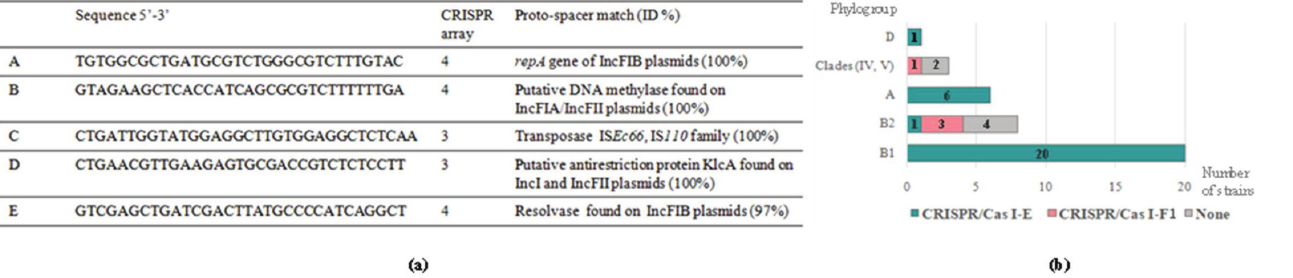
Figure 2. ( a ) Complete spacer sequences matching at least 97% with known plasmids or IS regions. ( b ) Distribution of CRISPR/Cas I-E and I-F1 systems among E. coli